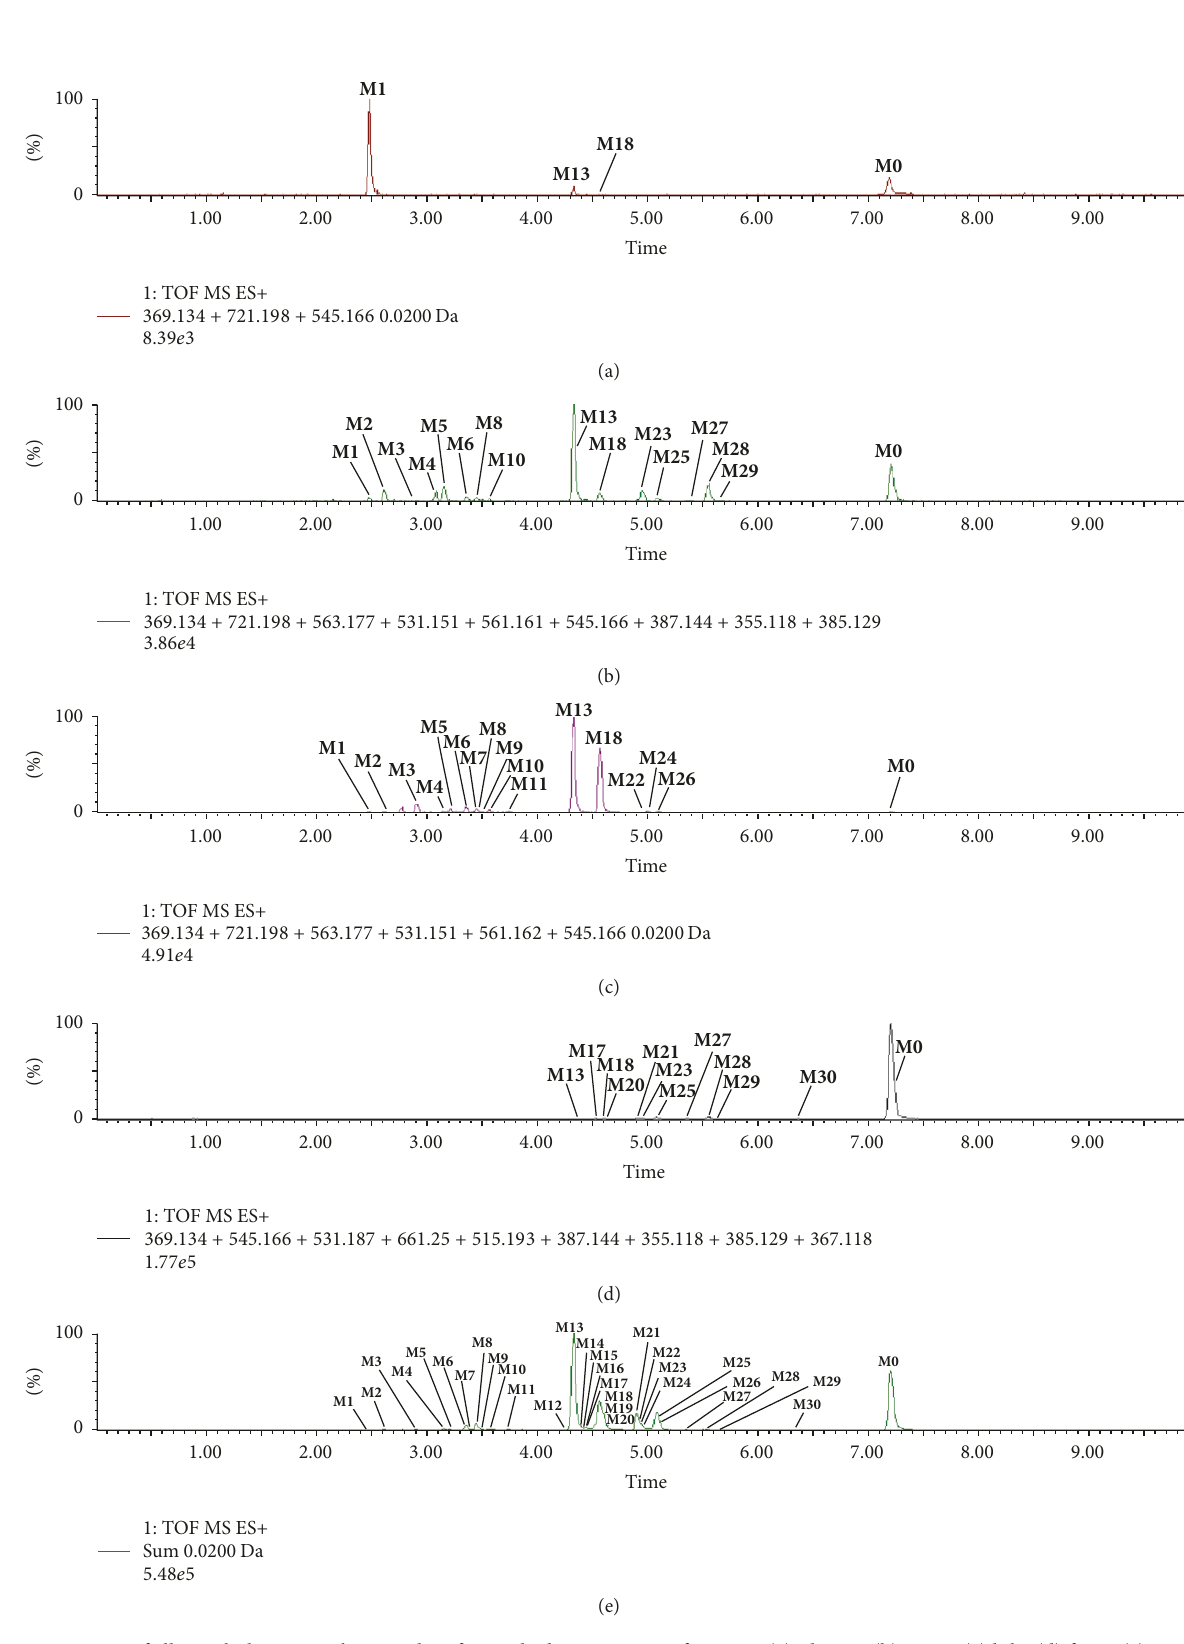
Figure 1: EICs of all metabolites in rat biosamples after oral administration of icaritin. (a) Plasma; (b) urine; (c) bile; (d) feces; (e)